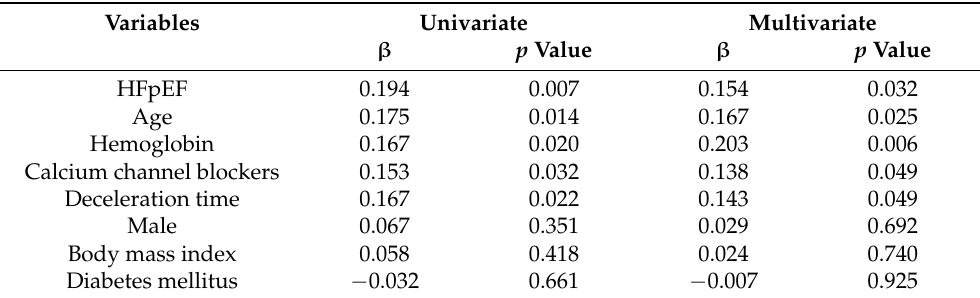
Figure 4. Box plot of the iBNP-to-BNP ratio in HFpEF and HFrEF. HF, heart failure; BNP, brain natriuretic peptide; iBNP, serum-induced BNP expression; pEF, preserved ejection fraction; rEF, reduced ejection fraction. * p < 0.05 vs. HFrEF. Table 2. Univariate analysis and multivariate regression analysis of the ratio of iBNP to BNP in patients with